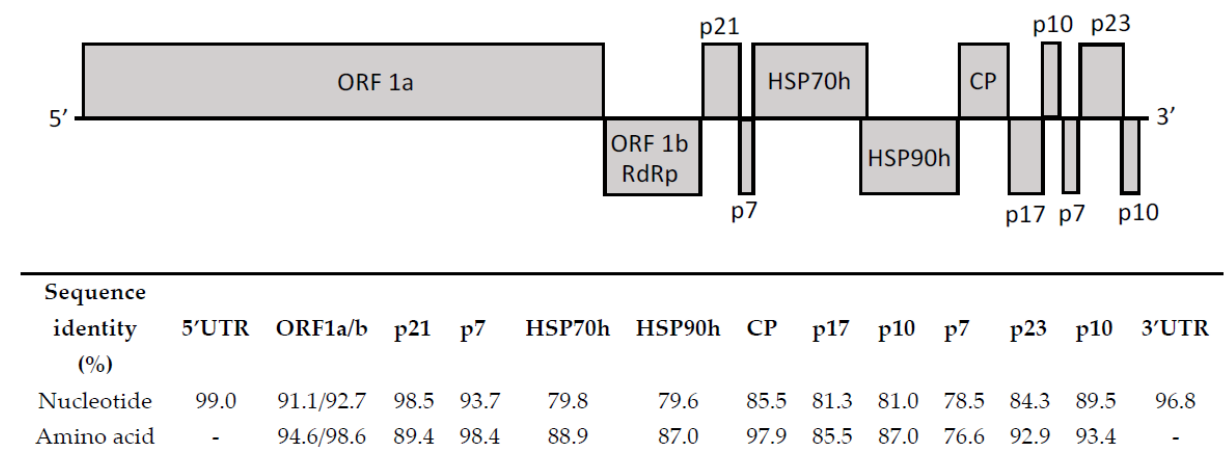
Figure 2. Genomic structure of OLYaV and ORFs is indicated. Percentages of sequence similarity at nucleotide and amino acid levels for each ORF, as well as pairwise identity for 5′ and 3′ UTRs between the Spanish OLYaV isolate V64 and the Brazilian isolate CS1 are shown.